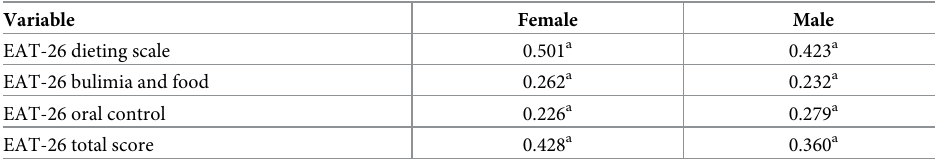
Table 4. Correlation between ORTO-R and EAT-26 scores by